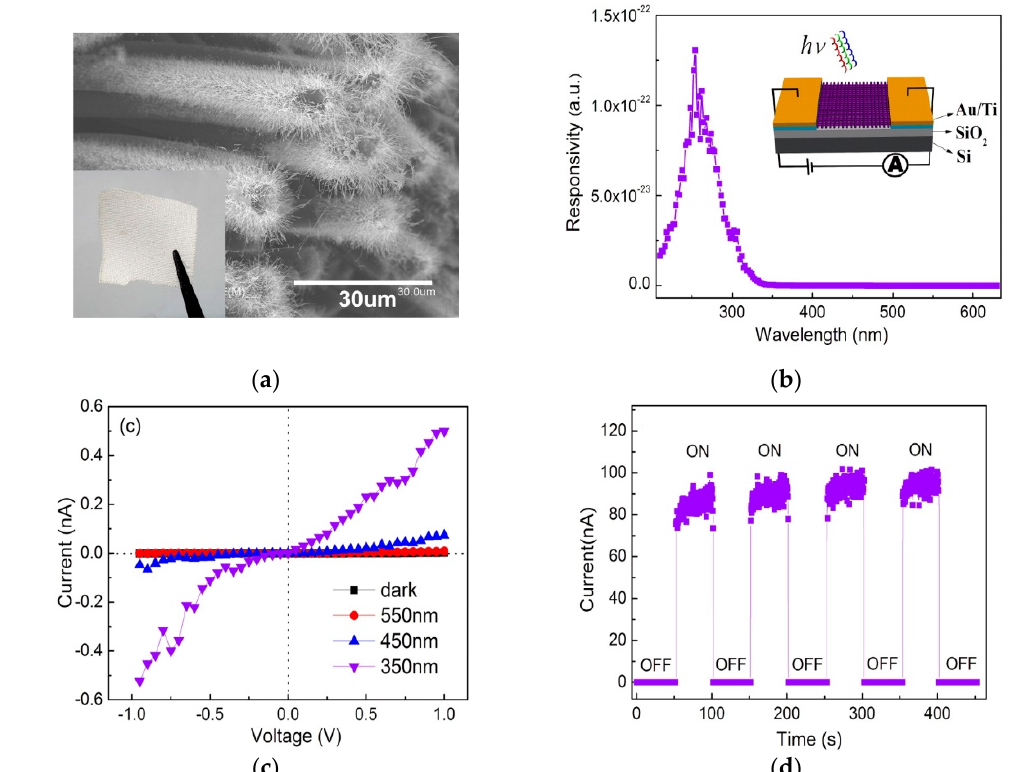
Figure 4. ( a ) Cross-sectional SEM image of 3D SnO 2 nano array; ( b ) Spectral response of the device; ( c ) I-V curves under different wavelengths and dark conditions; ( d ) Time–response curve of the device. Reprinted with permission from [72]. Copyright 2013 American Chemical Society.